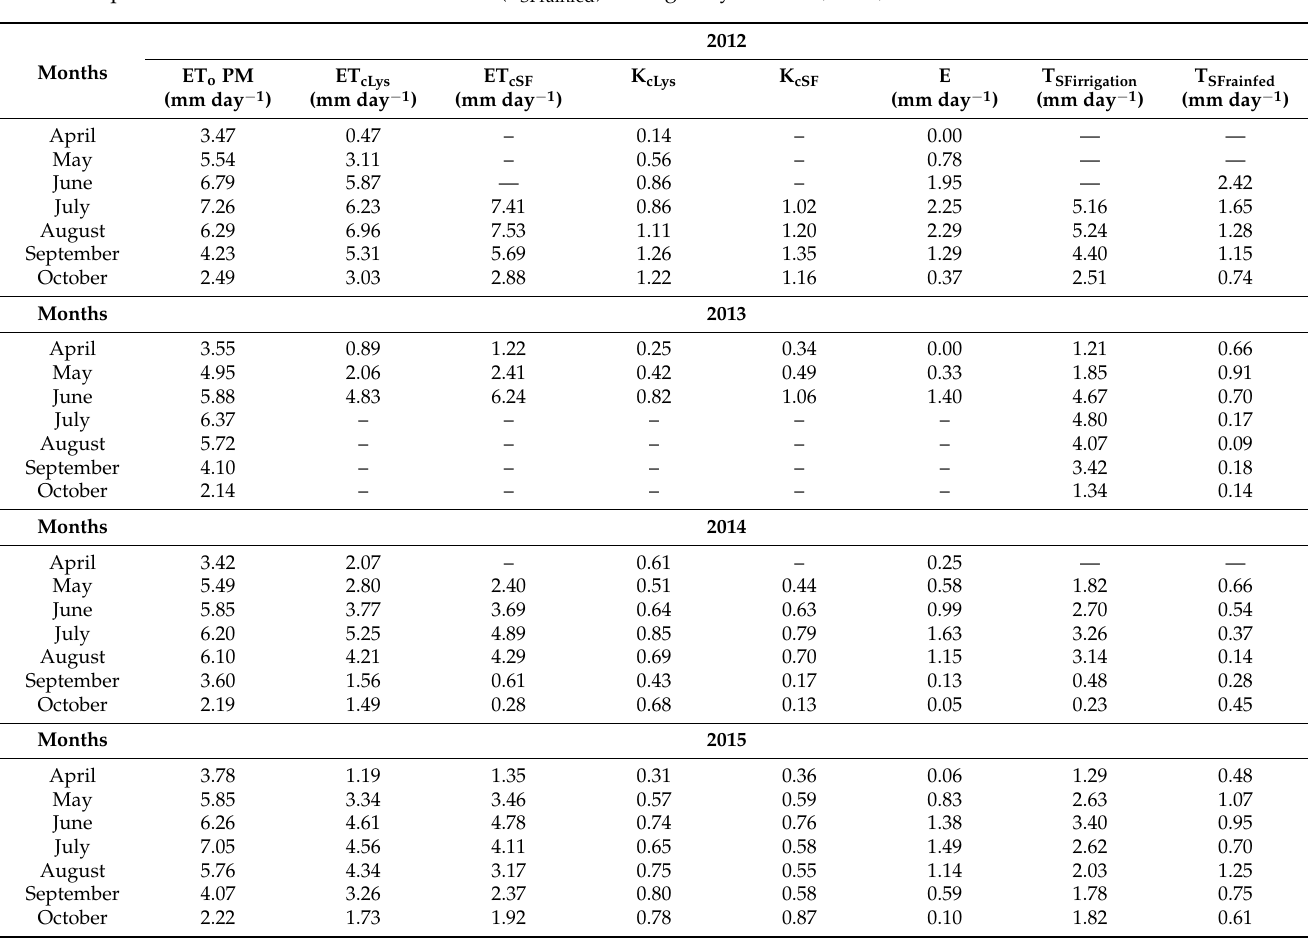
Table 2. Monthly average daily values, from April to October, of the reference evapotranspiration (ET o PM), crop evapo- transpiration in the lysimeter (ET cLys ), crop evapotranspiration obtained with the sap flow sensors (ET cSF ) in the irrigation treatment, crop coefficient obtained with the lysimeter (K cLys ), crop coefficient obtained with T SF + E (K cSF ), evaporation (E), transpiration obtained with the sap flow sensors in the irrigation treatment (T SFirrigation ) and transpiration obtained with the sap flow sensors in the rainfed treatment (T SFrainfed ) during the years 2012, 2013, 2014 and 2015.